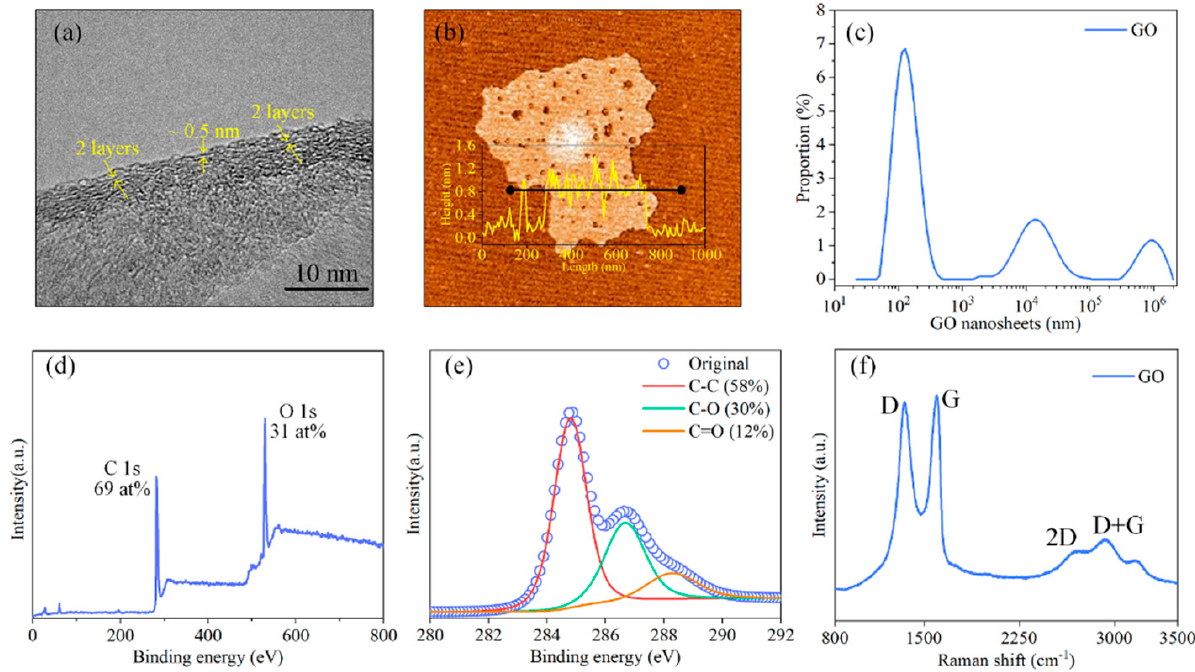
Figure 2. ( a ) HRTEM image showing the layered structure of GO nanoflakes with an interlayer spacing of approximately 0.5 nm, ( b ) AFM image showing the thickness of GO single layer is approximately 0.8 nm, ( c ) lateral size distribution of GO nanoflakes, ( d ) XPS spectrum of GO nanoflakes showing the C/O ratio is approximately 69:31, ( e ) XPS spectrum showing chemical bond within GO, and ( f ) Raman spectrum showing the typical D, G, 2D, and D + G bands of GO.